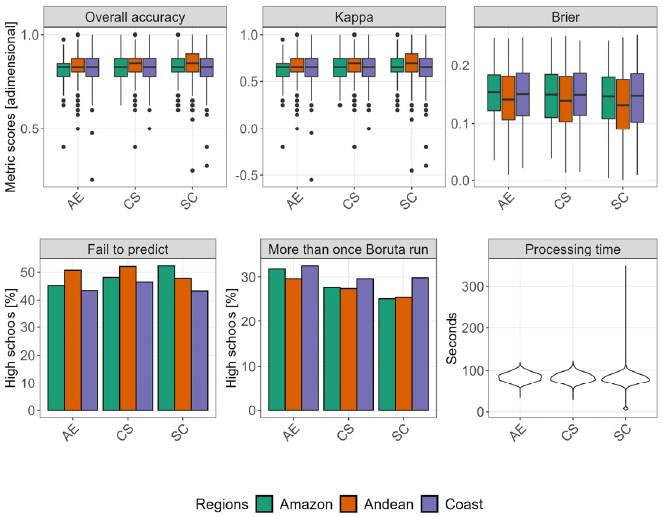
Figure 4. Accuracy metrics, model performance, and processing time summarized by region and theme group.